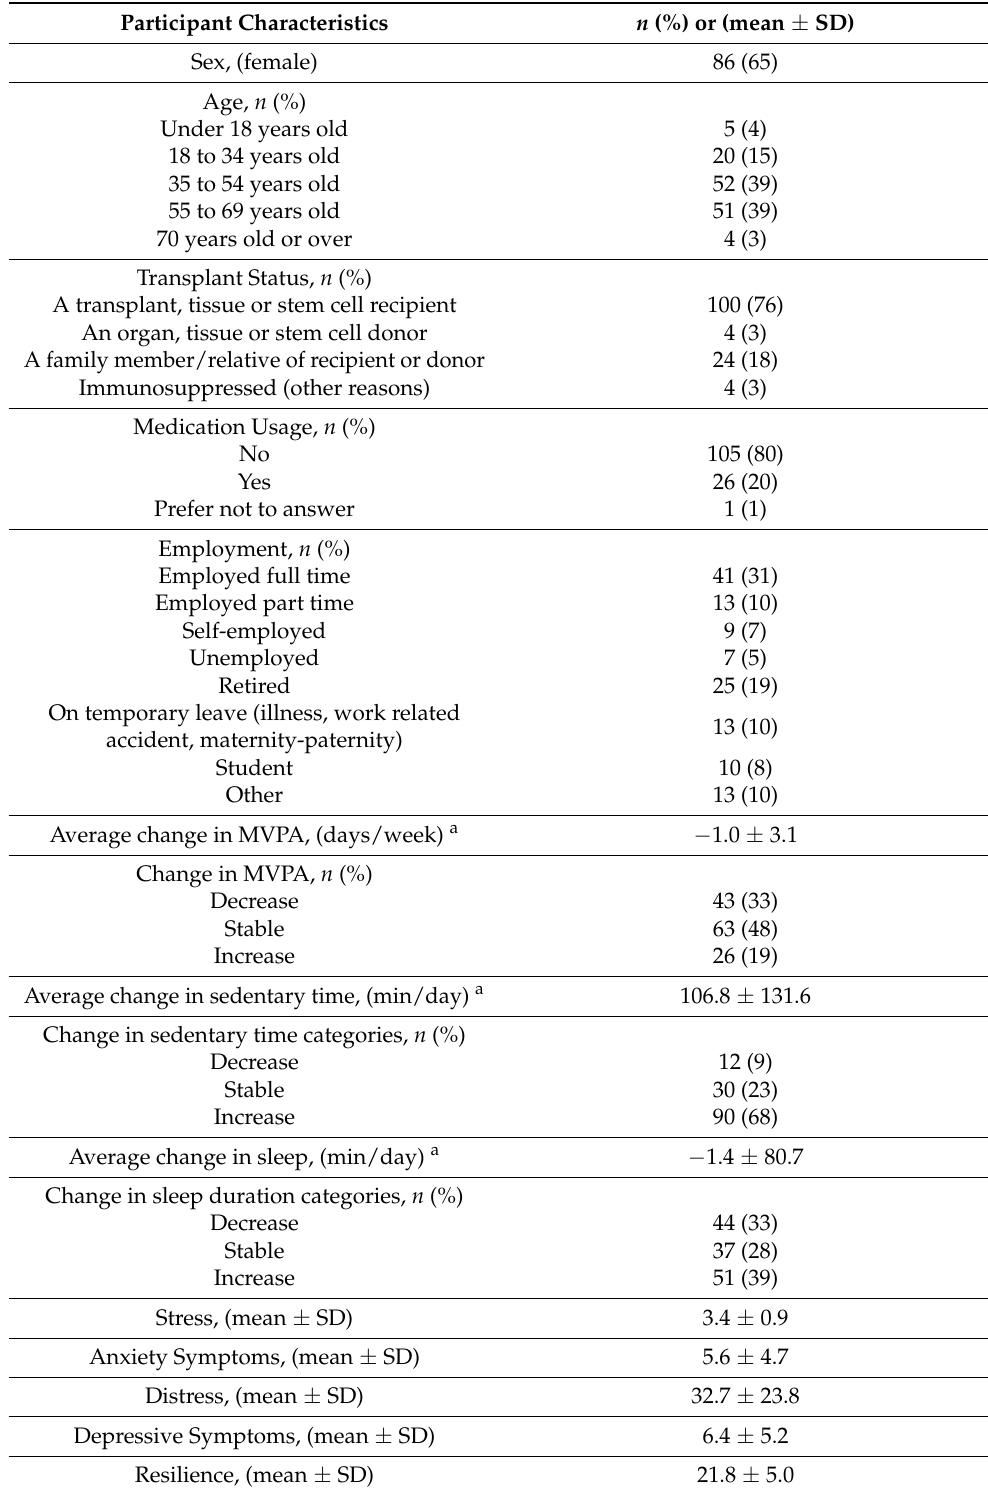
Table 1. Participant Characteristics ( n = 132) a